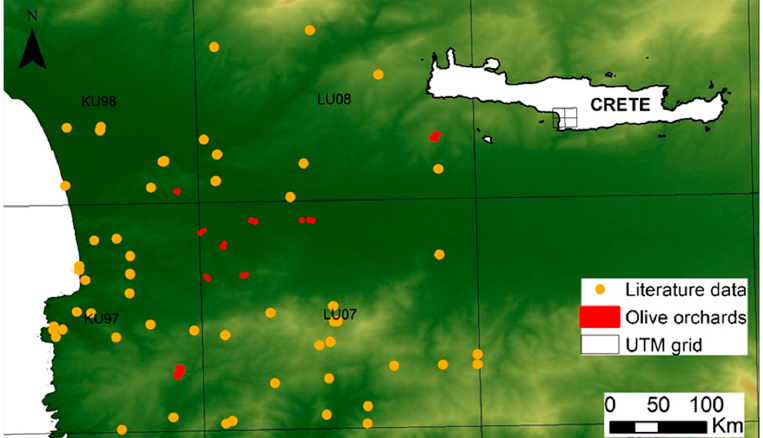
Figure 1. Map of the study area. The olive orchards are shown in red. The literature data are represented by orange dots. The study area is divided into the four (4) Universal Transverse Mercator (UTM) grid cells.